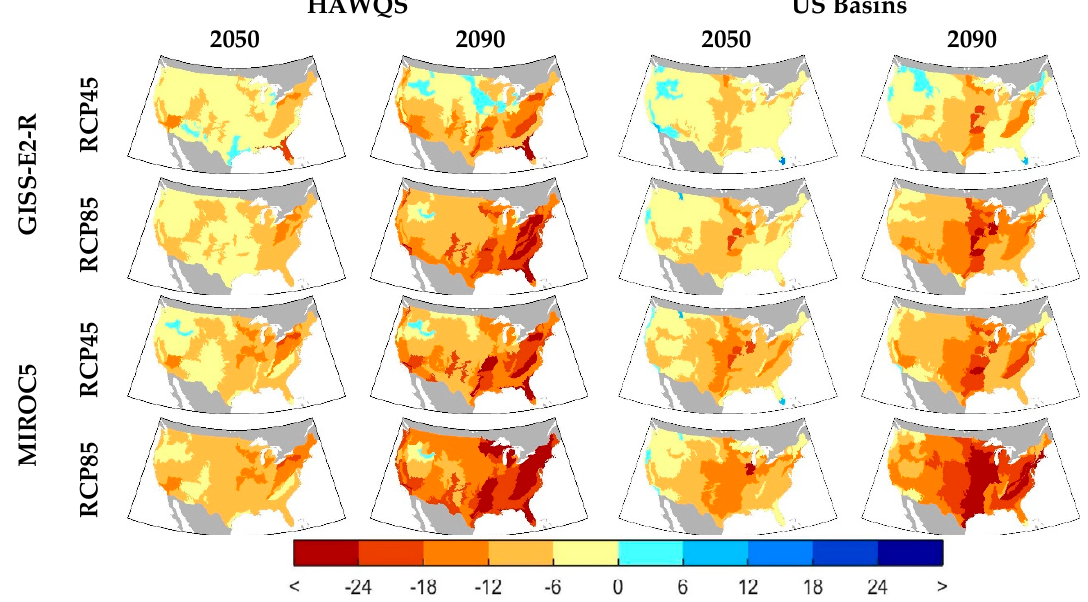
Figure 11. Changes in mean ( left ) HAWQS and ( right ) US Basins levels of the Climate ‐ Water Quality Index at the Level ‐ III Ecoregion scale for both the GISS ‐ E2 ‐ R and MIROC5 climate models, two emissions scenarios, and two eras.